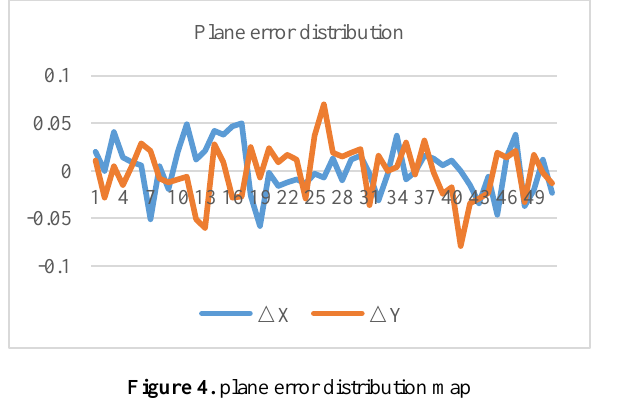
Figure 4. plane error distribution map